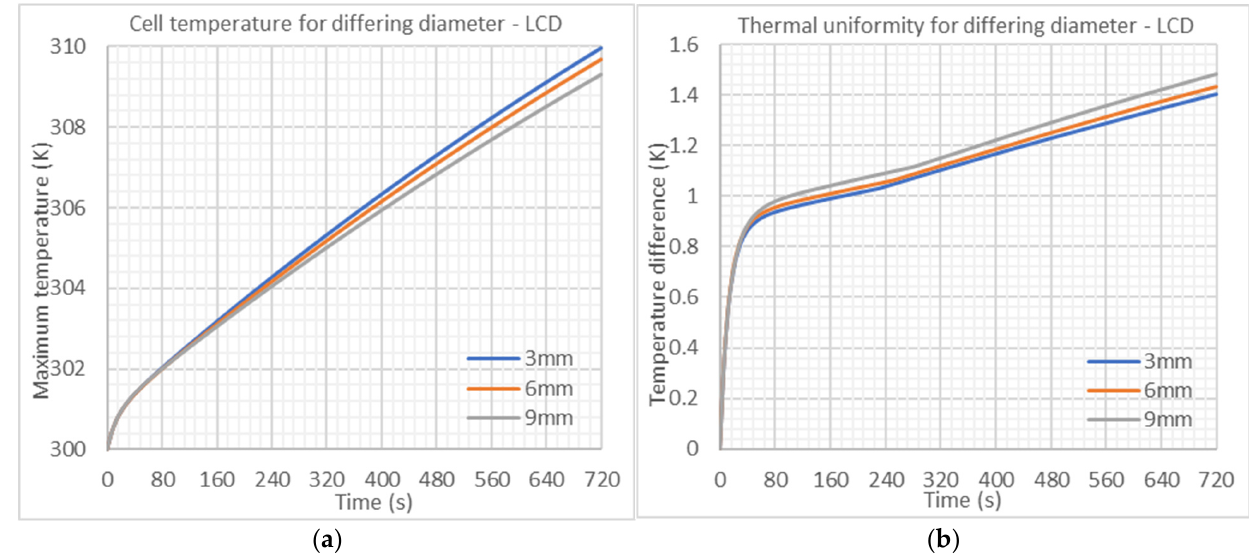
Figure 8. LCD—effects of channel diameter on: ( a ) Maximum cell temperature; ( b ) Cell temperature difference.